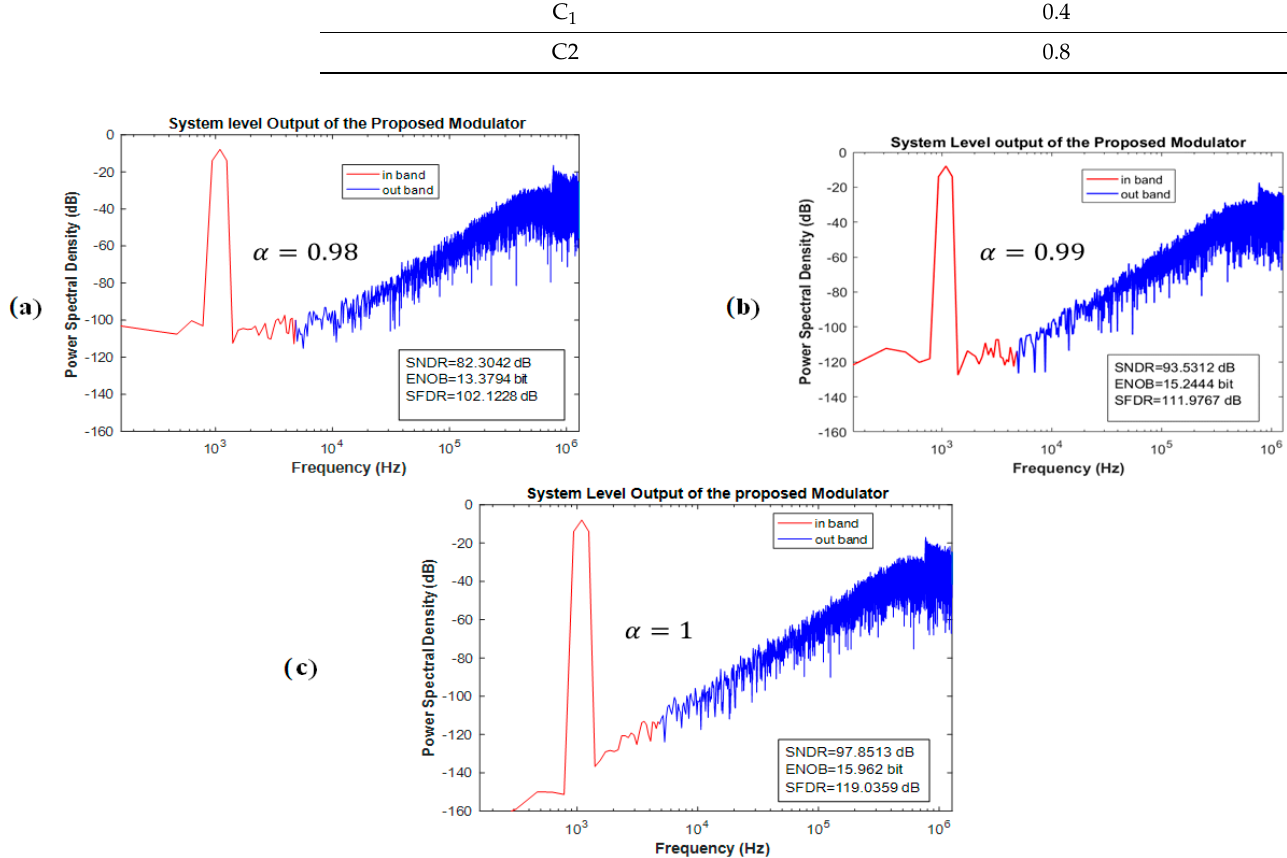
Figure 3. System level output of the proposed modulator for di ff erent fi lters’ ampli fi er DC gain: ( a ) α = 0.98 and ( b ) α = 0.99 and ( c ) α = 1.